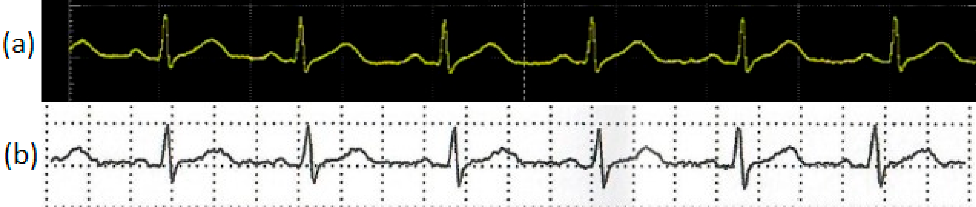
Figure 16. I-Lead ECG signal comparison from human volunteer: ( a ) Upper trace: signal using the AD8232 microchip with oscilloscope hardware: Analog Discovery; and ( b ) Lower trace: medical desktop ECG Mitral M12USB. These ECG signals traces were taken over seven days from the same